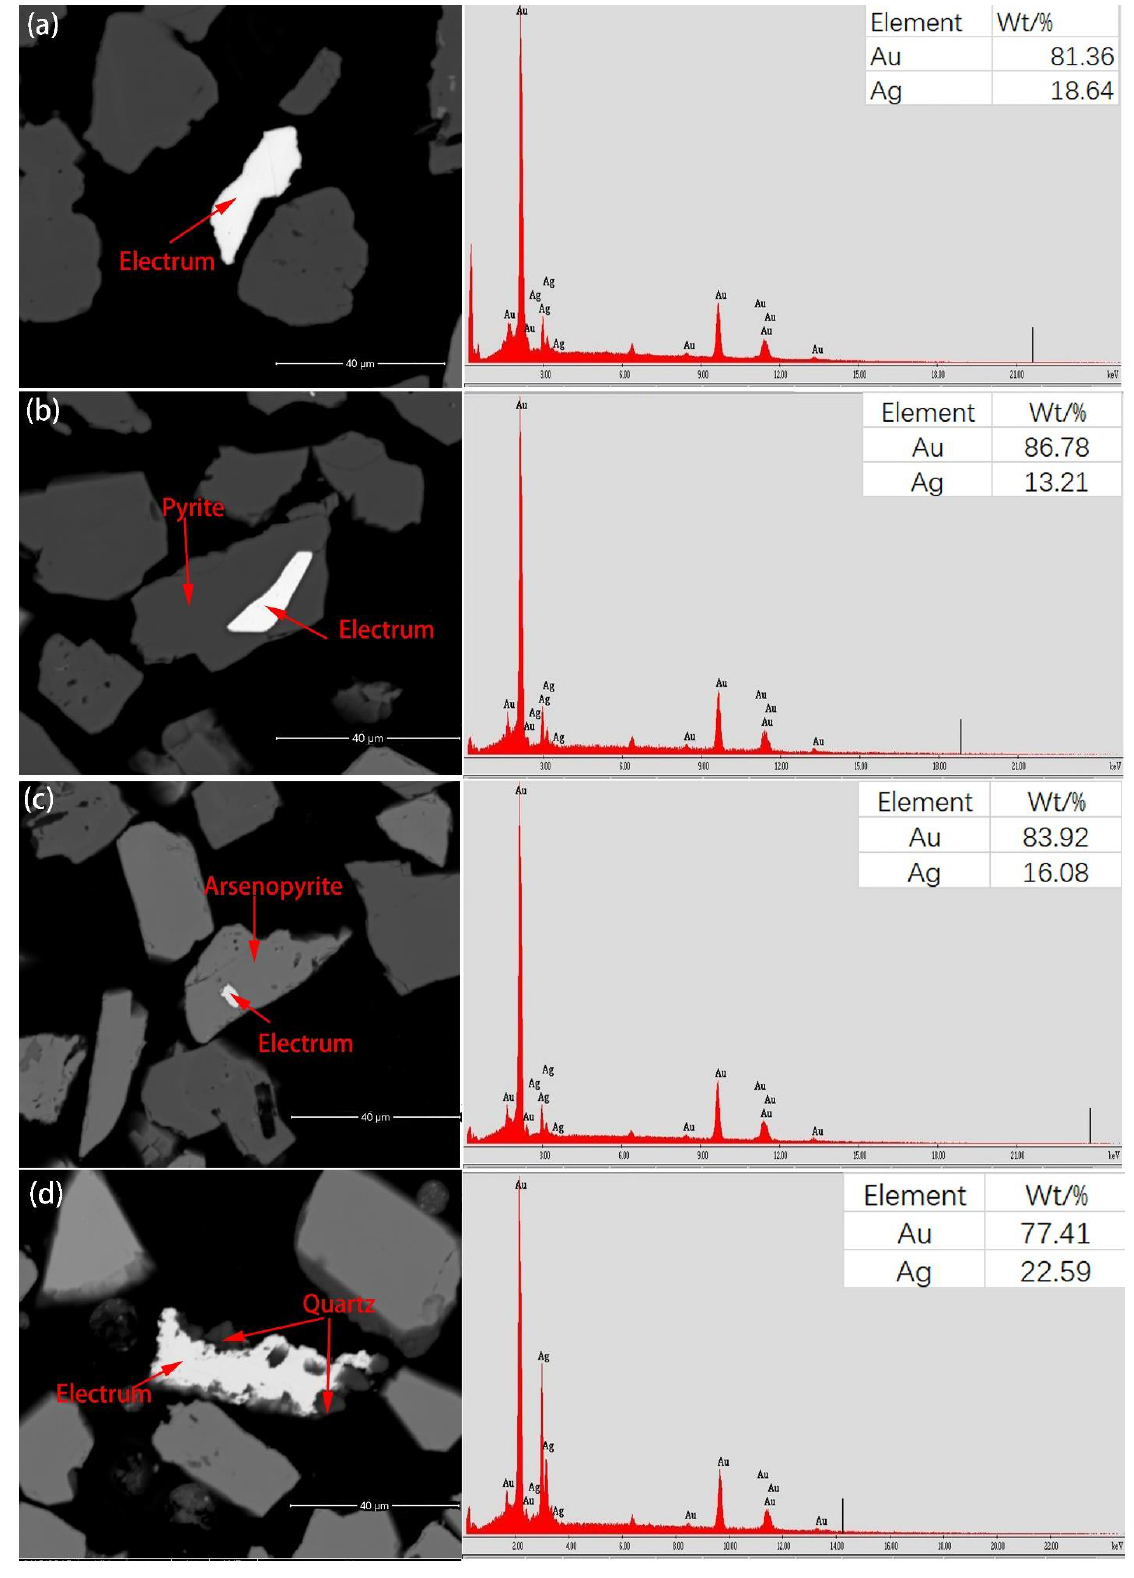
Figure 2. Micrographs of ( a ) free electrum, ( b ) electrum enclosed by pyrite, ( c ) electrum enclosed by arsenopyrite and ( d ) electrum enclosed by quartz.